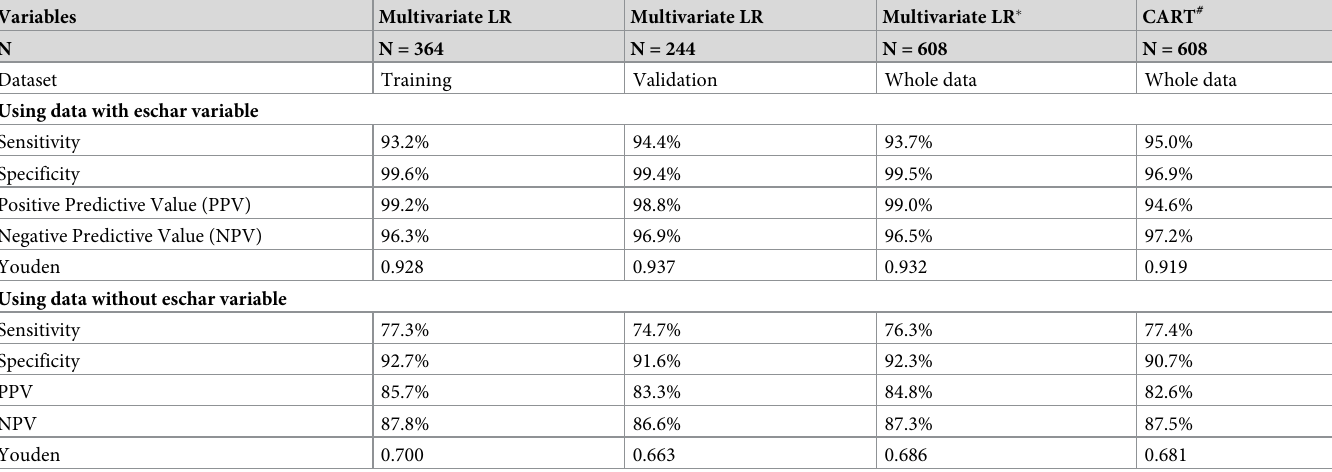
Table 4. Model validation: Accuracy of Scrub typhus Prediction Models derived by Multivariate Logistic Regression vs. CART.